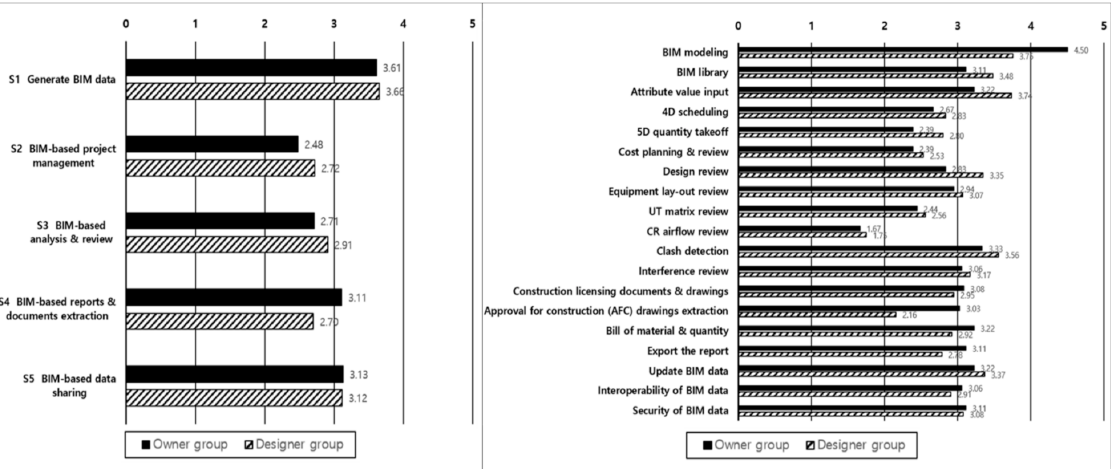
Figure 6. Current competency level of ‘Skills’ domain